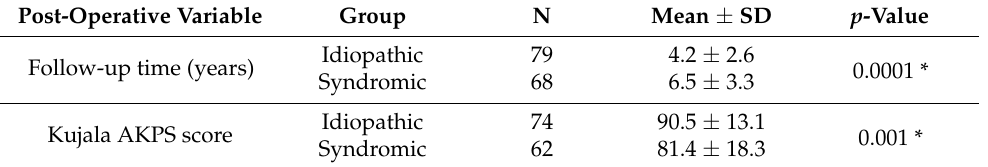
Table 4. Post-operative